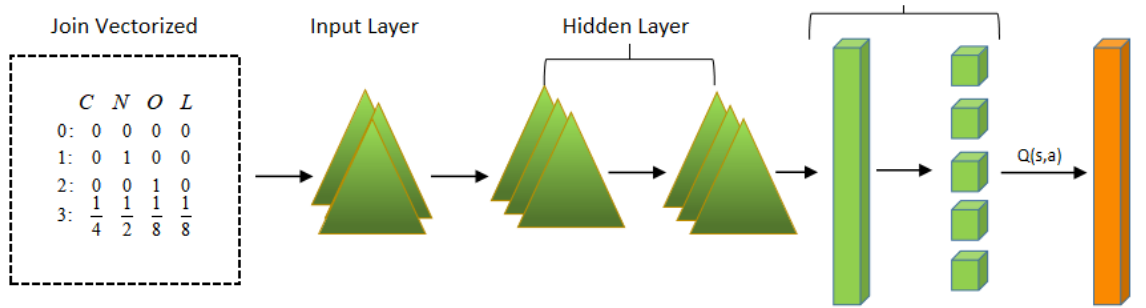
Figure 4. Architecture of the query cost prediction model (input to the network after obtaining the SQL vector, join on the query plan tree, and output of the long-term plan cost at a fully connected layer after network